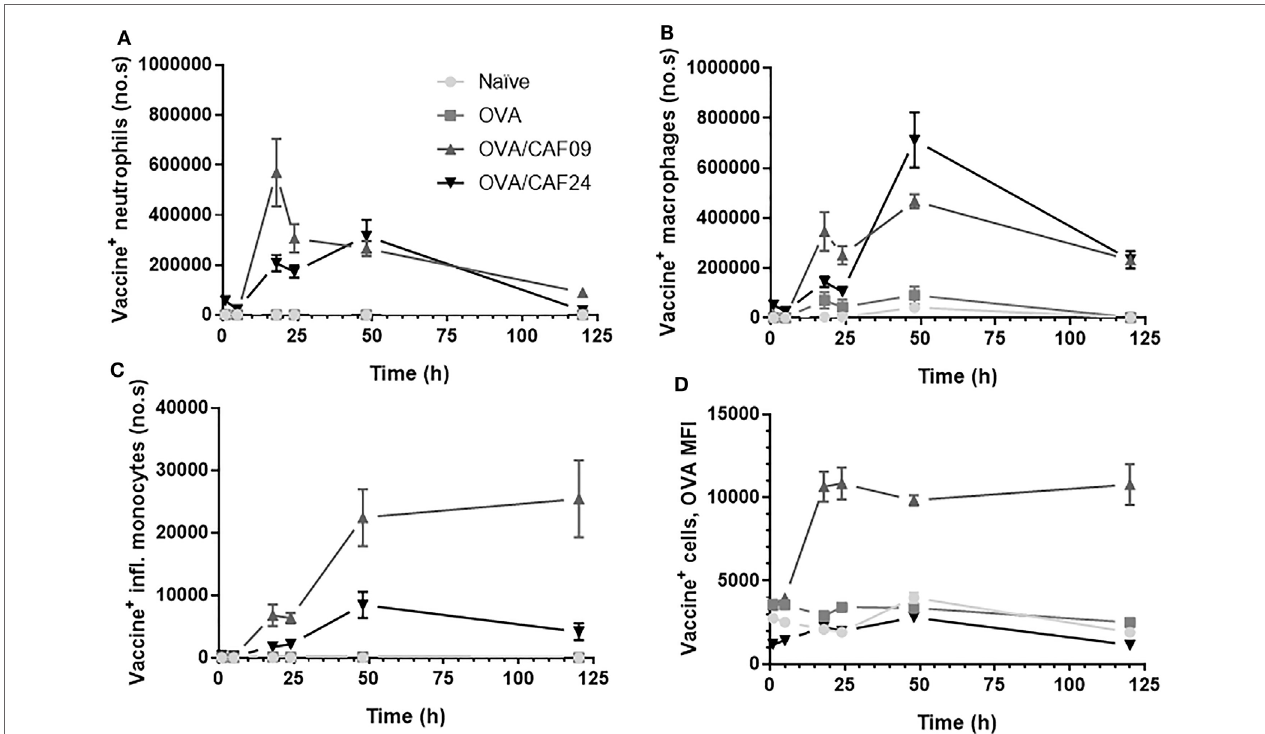
FigUre 4 | Number of (a) vaccine + (adjuvant + antigen + ) neutrophils, (b) vaccine + macrophages, and (c) vaccine + inflammatory monocytes in muscle following intramuscular administration of ovalbumin (OVA) adjuvanted with cationic adjuvant formulation (CAF)09 and CAF24a as compared to naïve mice and mice immunized with unadjuvanted OVA. (D) Mean fluorescence intensity (MFI) of OVA in vaccine + muscle cells. n = 2 (naïve, unadjuvanted OVA) and n = 6 (OVA/CAF24a and OVA/CAF09). Data points represent mean ±